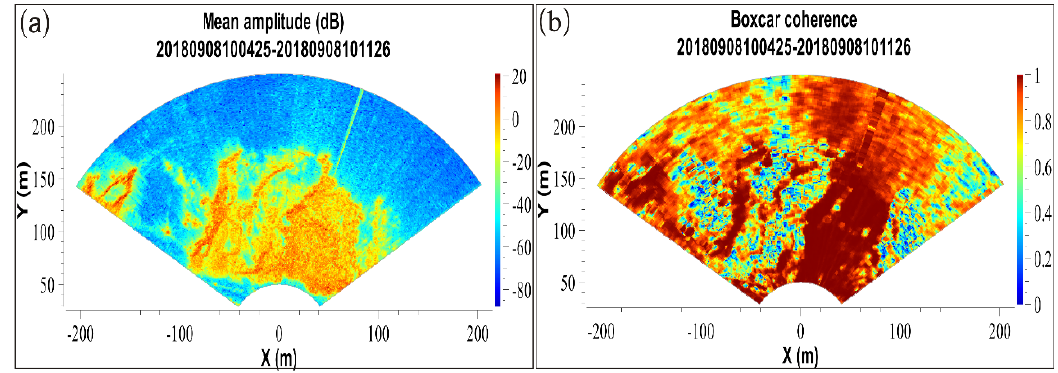
Figure 6. Mean amplitude and coherence maps: (a) mean amplitude; (b) boxcar coherence.